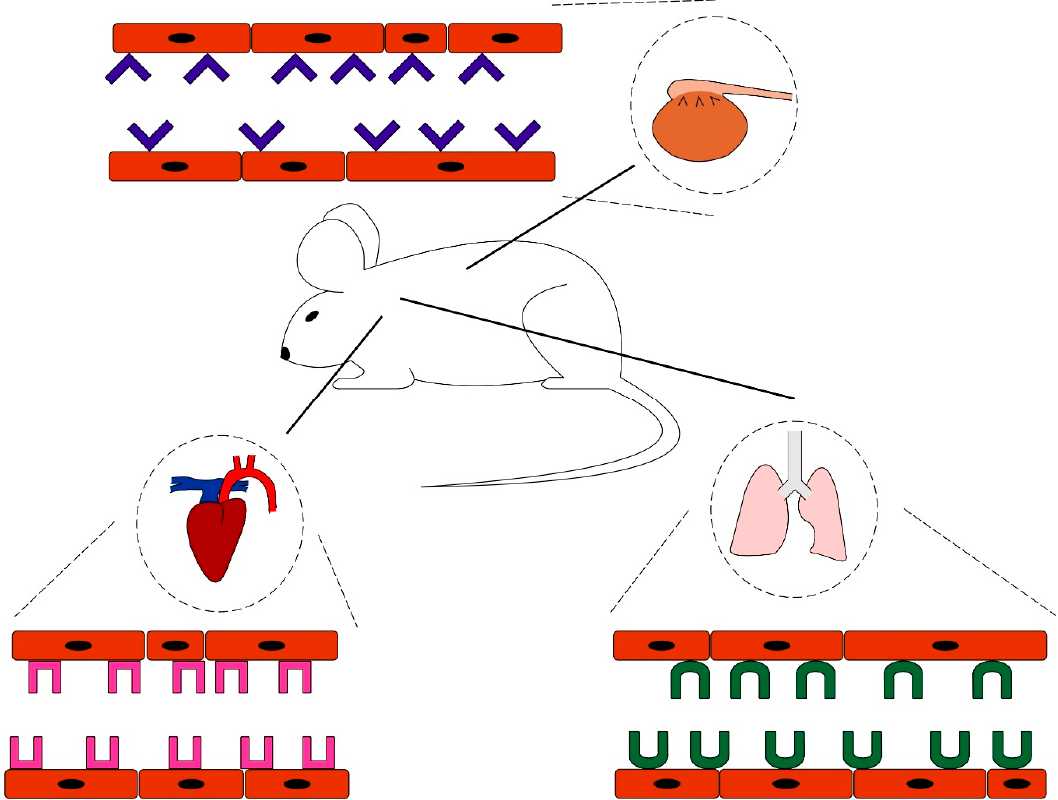
Figure 1. The vascular zip codes. Each tissue has its own unique molecular structure in the luminal side of its vessels. These molecules function as receptors for tissue homing molecules such as peptides. Combining a homing peptide with another molecule creates a compound that can home to its target tissue. Homing diminishes the amount of the drug needed and helps to avoid side effects of the medication.